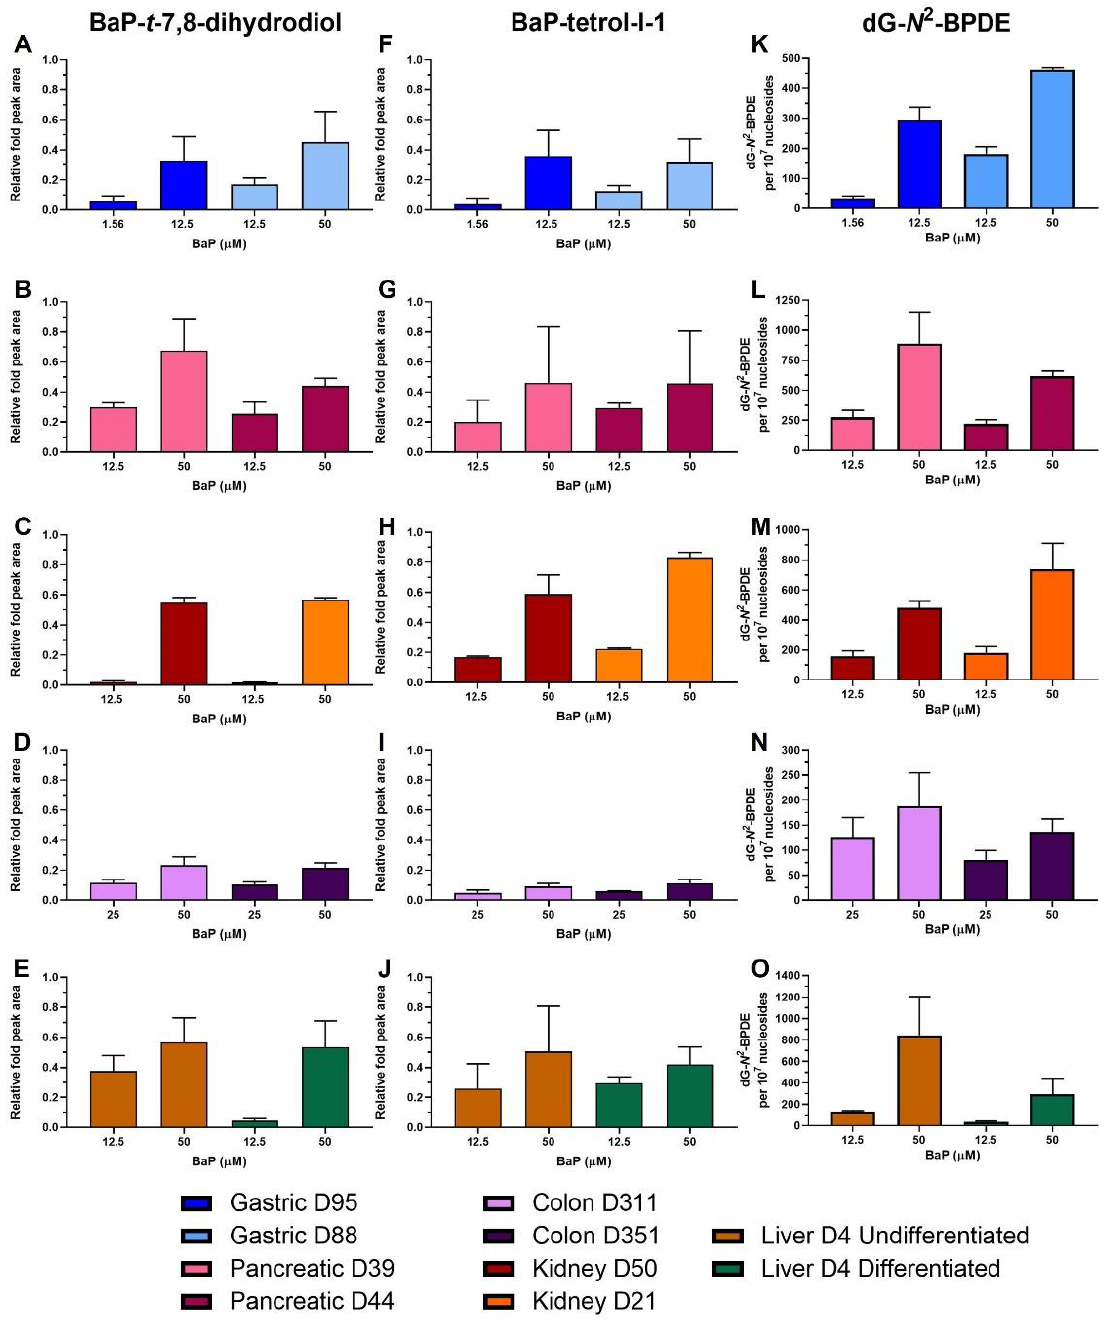
Figure 4. BaP metabolite and DNA adduct levels in human tissue organoids after BaP treatment. Gastric D95 and D88; ( A , F , K ), pancreatic D39 and D44; ( B , G , L ), kidney D50 and D21; ( C , H , M ), colon (D311 and D351; ( D , I , N ) and liver undifferentiated and differentiated (D4; ( E , J , O ) organoids were treated with the indicated BaP concentrations for 48 h. Vehicle controls (0.5% DMSO) were included (not shown). The formation of BaP-t-7,8-dihydrodiol ( A – E ) and BaP-tetrol-l-1 ( F – J ) was determined by HPLC analysis. Metabolite levels are presented as peak area relative to phenacetine (arbitrary units). dG- N 2 -BPDE adduct formation was quantified using LC-ESI-MS/MS ( K – O ). Results are shown as mean ± SD (n ≥ 3).